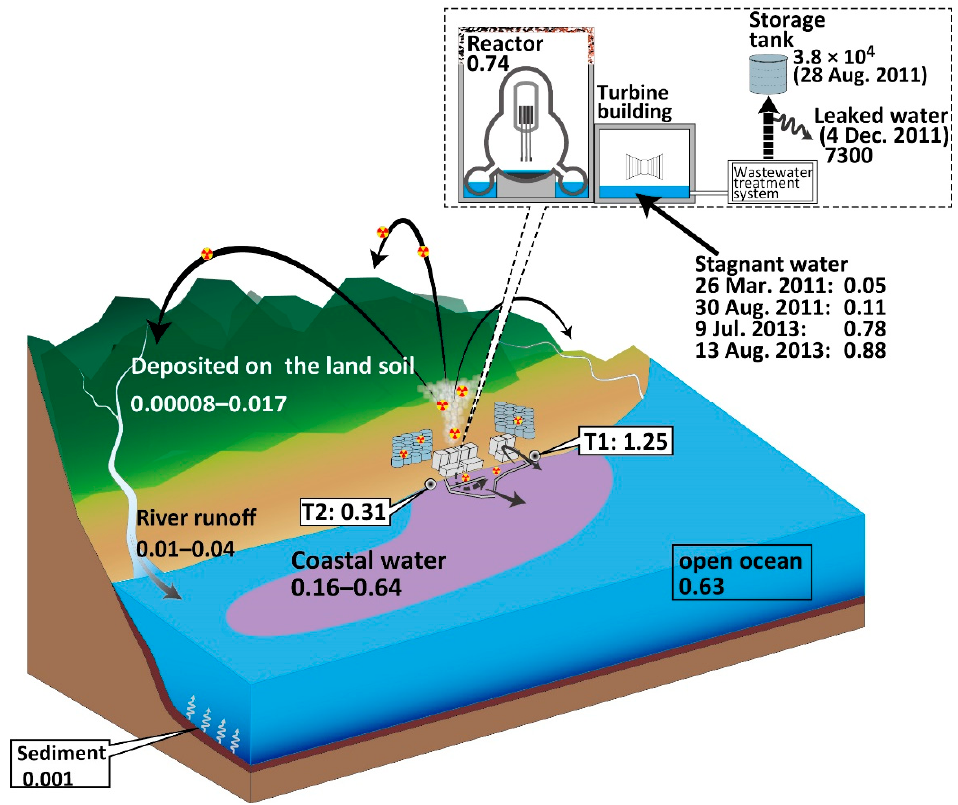
Figure 4. The 90 Sr/ 137 Cs activity ratios in the environment and the FDNPP site. The 90 Sr/ 137 Cs activity ratio in seawater near the FDNPP was consistent with those from the monitoring points, T1 and T2 [12]. Soil [4] and sediment [24] samples had extremely low 90 Sr/ 137 Cs activity ratios. Table 2. FDNPP site-derived 90 Sr ( 90 Sr corr. ) and 137 Cs ( 137 Cs corr. ) activities and 90 Sr corr. / 137 Cs corr. activity ratios.